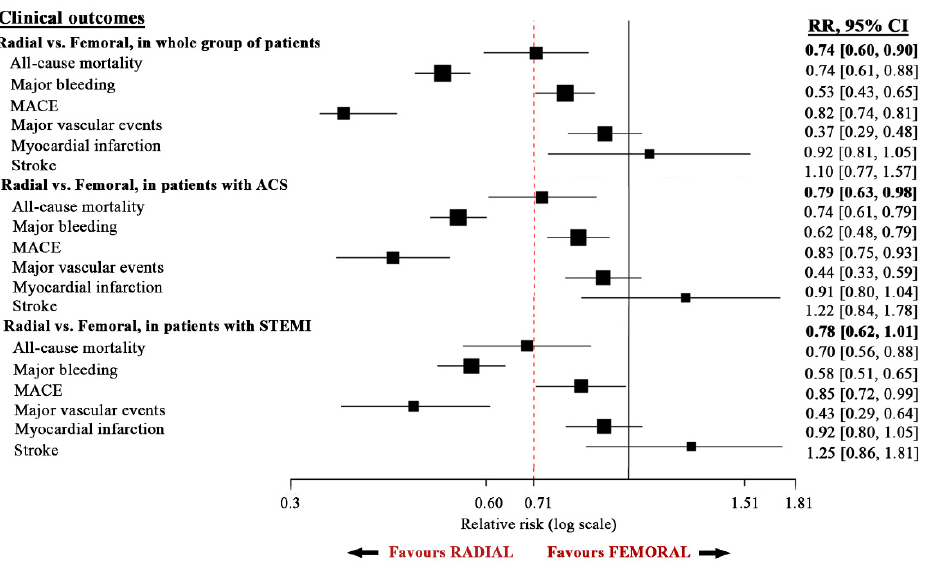
Figure 4. Summary of outcome in all study